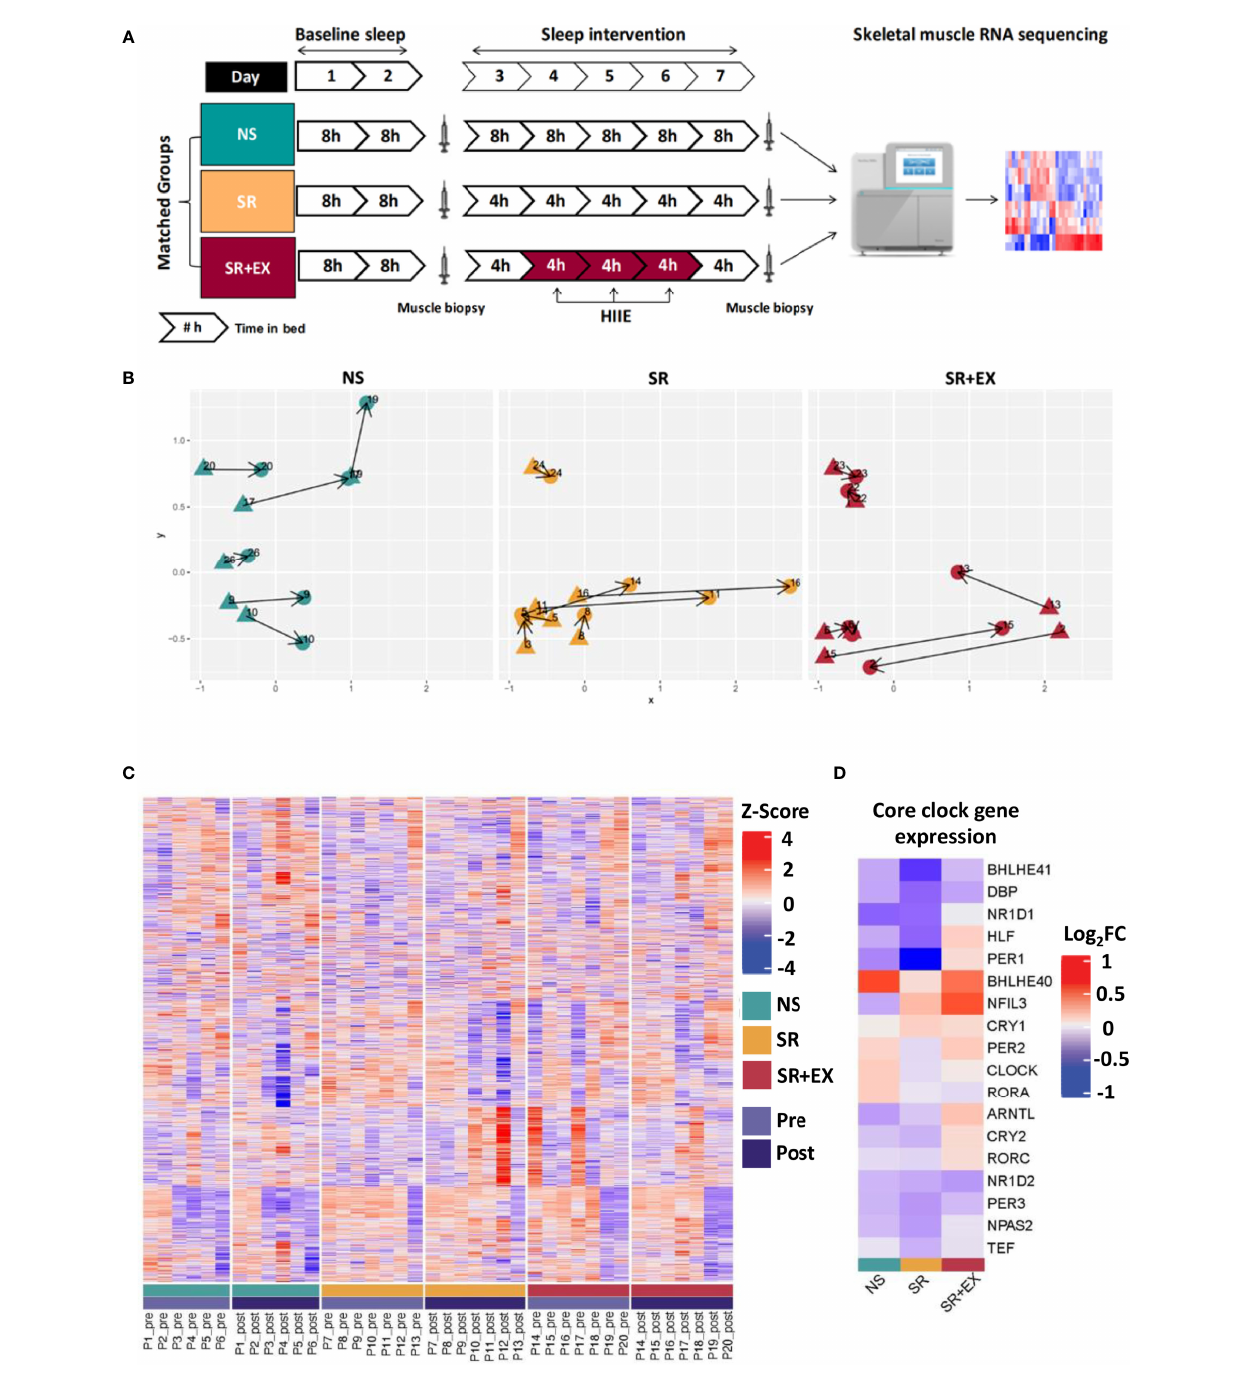
FIGURE 1 | (A) Study protocol and analysis overview. Participants were matched into one of three experimental groups. The study consisted of two nights of baseline sleep (8 h TIB), prior to 5 nights of either 8 h TIB (NS), or 4 h TIB (SR and SR+EX). The SR+EX group performed 3 sessions of HIIE on Day 4, 5 and 6. Skeletal muscle biopsies were collected pre- and post-intervention and underwent transcriptomic analysis. (B) Multidimensional scaling (MDS) plot showing distances between each group (blue = NS, yellow = SR, red = SR+EX), with each biopsy time points (pre- (triangles) or post-intervention (circles)). (C) Heatmap of relative expression levels of transcripts identi fi ed within the study. Individuals were grouped according to their intervention and time point (pre or post). (D) Changes in expression of core circadian clock genes for each group (Log 2 FC from pre- to post-intervention). Groupings include green = normal sleep [NS], yellow = sleep restriction [SR], red = sleep restriction and exercise [SR+EX], with Pre [light purple] and Post [dark purple]. NS – Normal Sleep, SR – Sleep Restriction, SR+EX – Sleep Restriction and Exercise, HIIE – High-intensity interval exercise, TIB – Time in